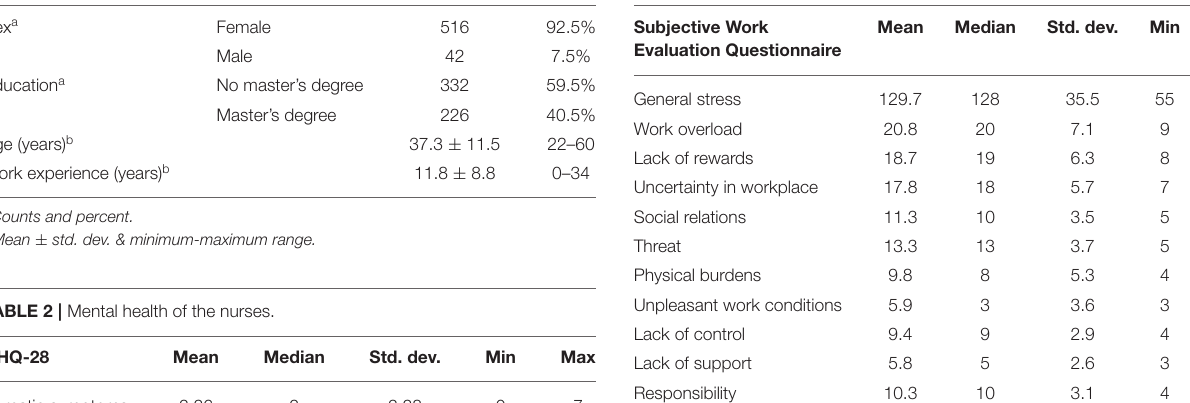
TABLE 3 | Subjective evaluation of negative work features.